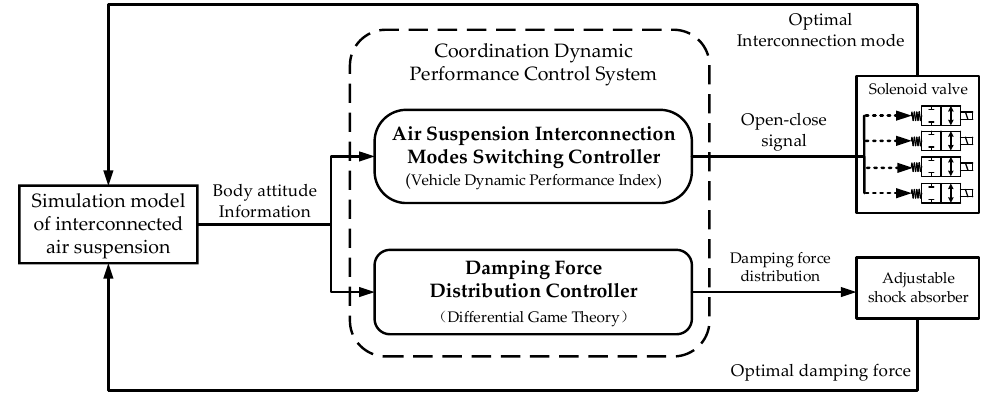
Figure 3. Control system of the IASS for coordinating dynamic characteristics.